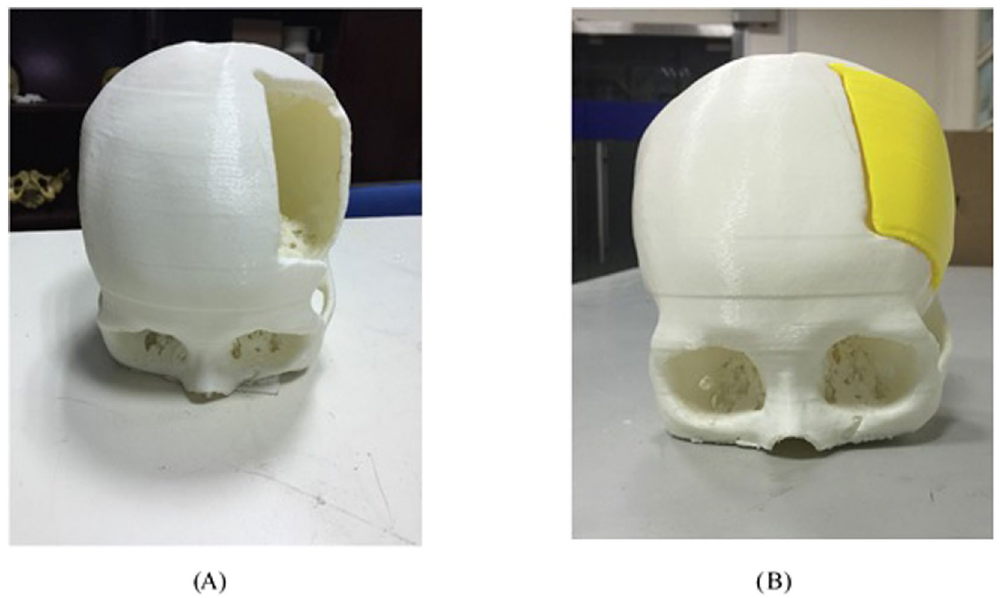
Figure 2. The 3D printed crania model and